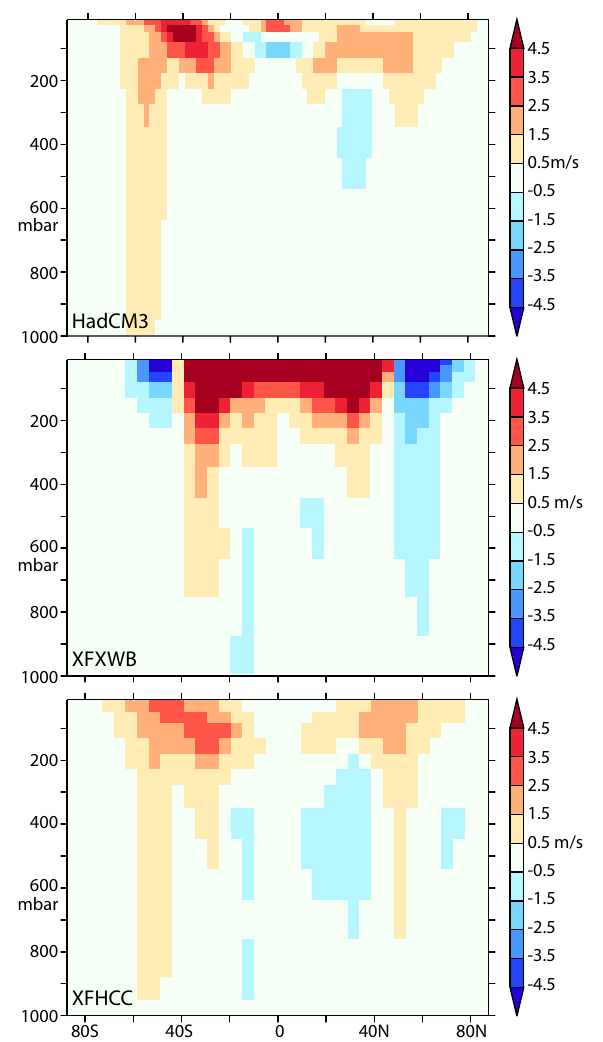
Fig. 7. Changes in annual average, zonal average winds at 2 × CO 2 in 1% CO 2 increase runs. Top: HadCM3; middle: XFXWB; bot- tom: